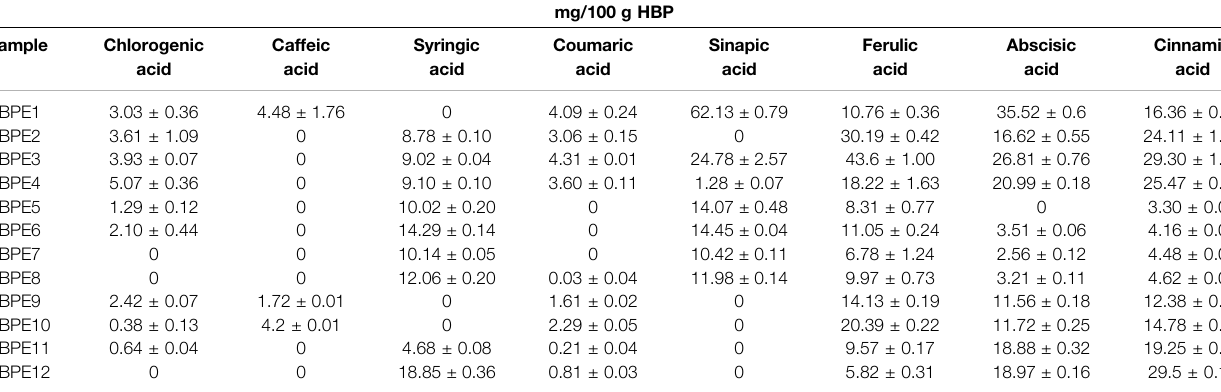
TABLE 3 | Phenolic acids and abscisic acid of honeybee pollen extracts (HBPEs) as determined by HPLC-DAD.